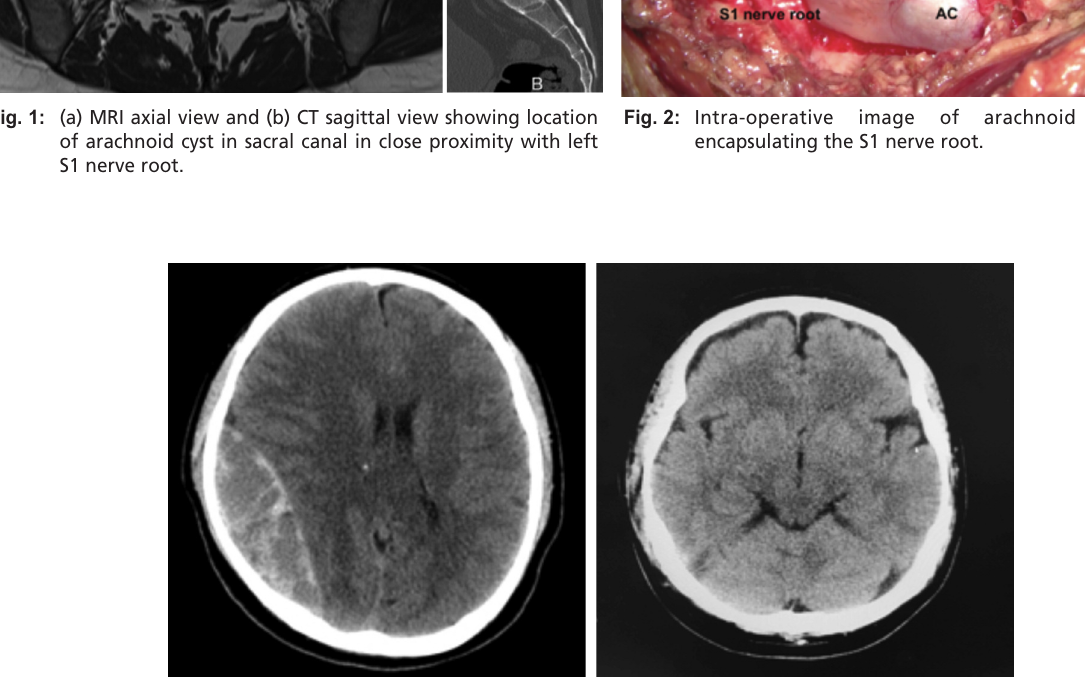
CT brain; (a) Right sided intracranial subdural hematoma at post-operative day three. (b) Resolution of hematoma after Fig. 3: evacuation.